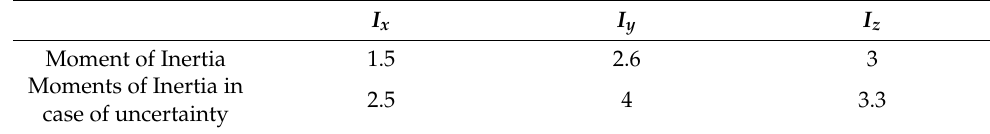
Table 1. Nominal and indeterminate moments of inertia (in Kg · m 2 ).